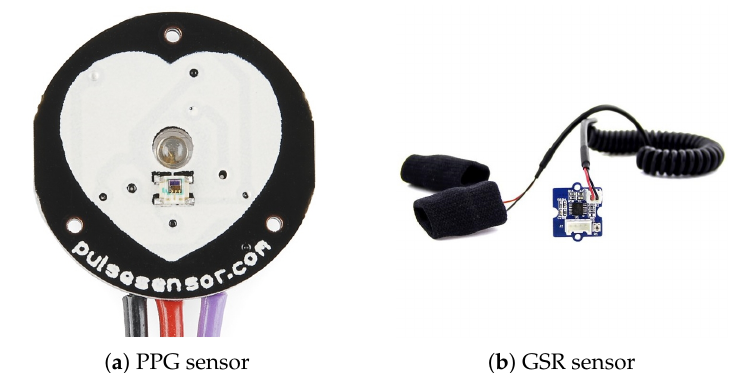
Figure 3. Photoplethysmography (PPG) and Galvanic Skin Response (GSR)